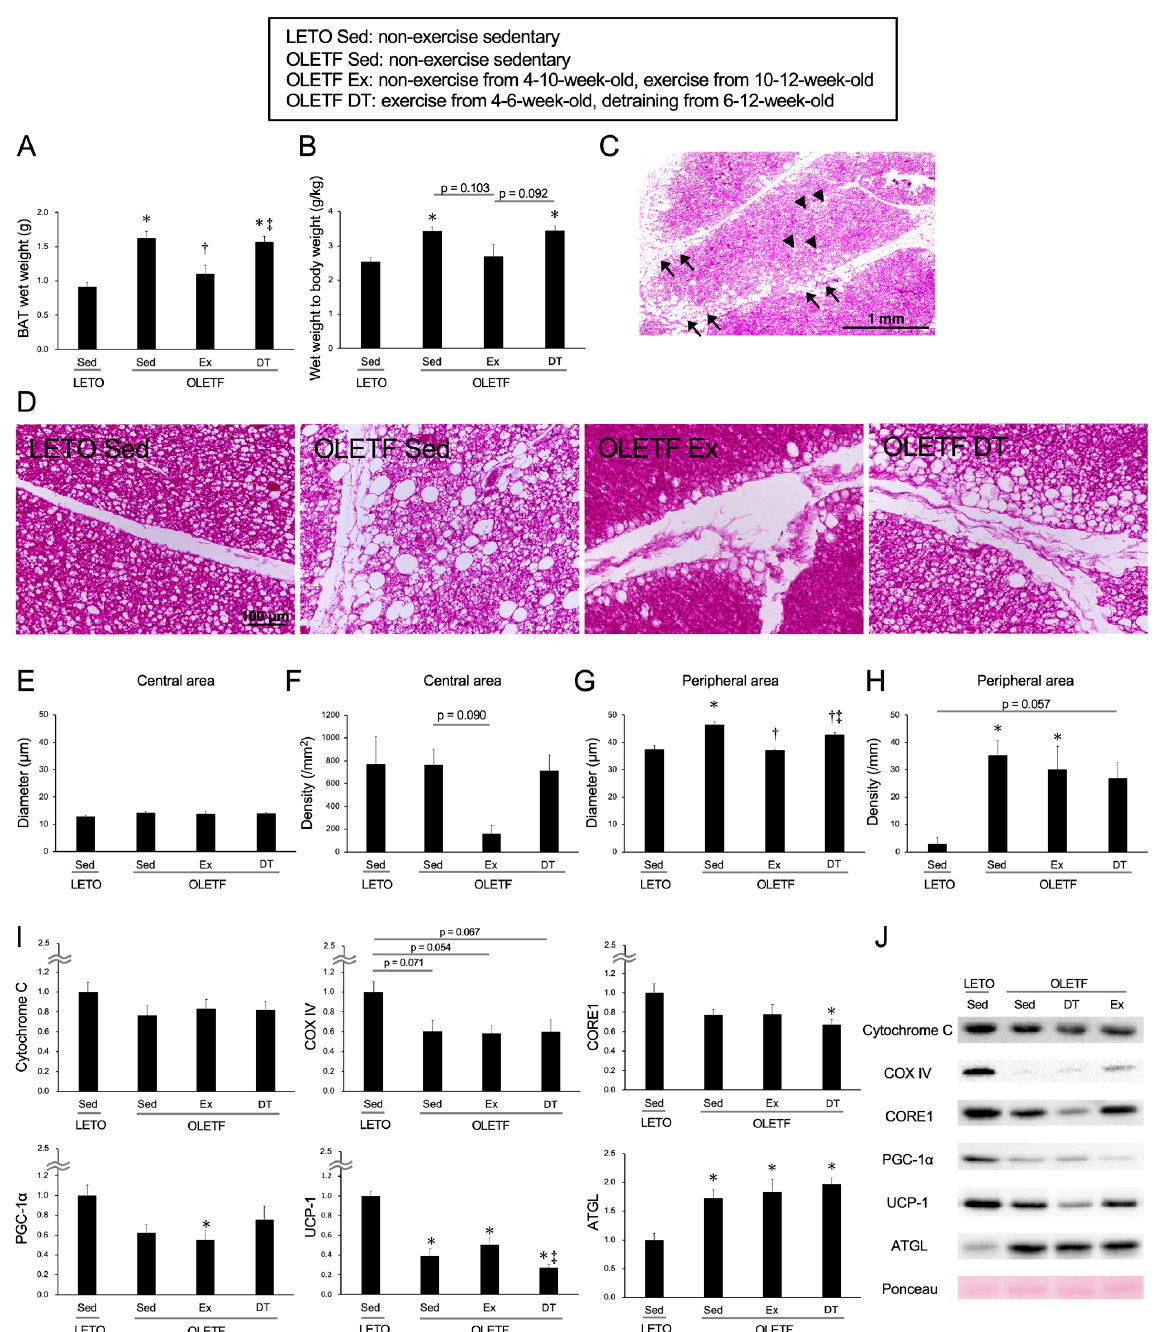
Figure 3. Chronic influences of exercise on brown adipose tissue at 12-weeks-old. ( A ) Wet weight of the brown adipose tissue; ( B ) Ratio of brown adipose tissue wet weight to body weight; ( C ) Representative section of brown adipose tissue stained with hematoxylin and eosin in the OLETF Sed group; ( D ) Representative sections in the peripheral area of the adipose lobule; ( E ) Diameter of whitened unilocular adipocyte in the central area of the lobule; ( F ) Density of whitened unilocular adipocyte in the central area of the lobule; ( G ) Diameter of hypertrophic unilocular adipocyte in the peripheral area of the lobule; ( H ) Density of hypertrophic unilocular adipocyte in the peripheral area of the lobule; ( I ) Expression levels of the proteins in the brown adipose tissue at 12-weeks-old; ( J ) Representative images for the proteins. OLETF DT, OLETF exercise from 4- to 6-weeks-old and non-exercise detraining from 6- to 12-weeks-old. Arrowheads indicate whitened unilocular adipocytes located in the central area of the adipose lobule. Arrows indicate hypertrophic unilocular adipocytes located in the peripheral area of the adipose lobule. Values represent means ± standard deviation. *, †, and ‡ show significantly different from the LETO Sed, OLETF Sed, and OLETF Ex groups, respectively, p <